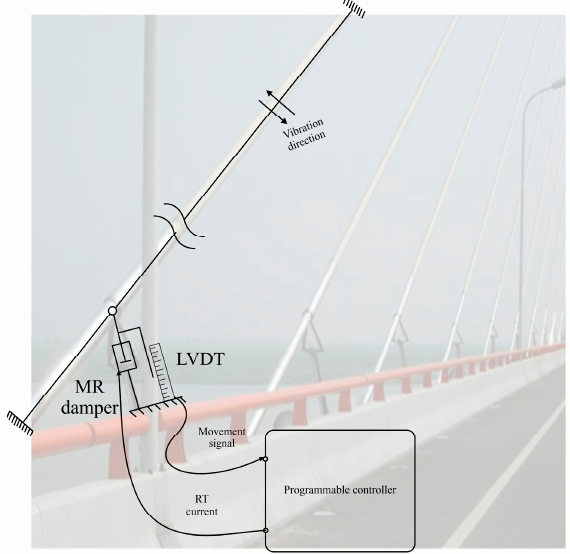
Figure 18. MR damper based programmable stay cable vibration control system [186].